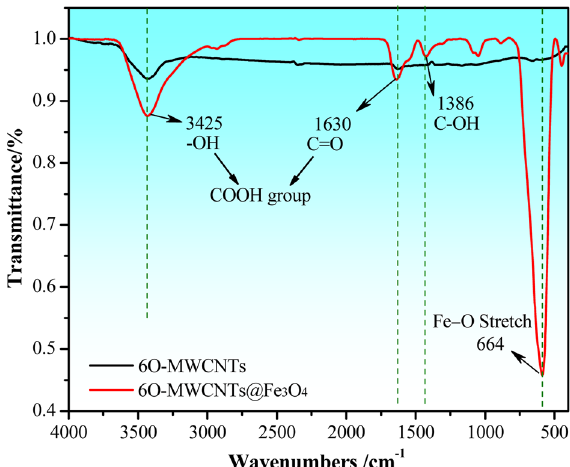
Figure 3. FTIR spectras of 6O-MWCNTs and 6O-MWCNTs@Fe 3 O 4 .